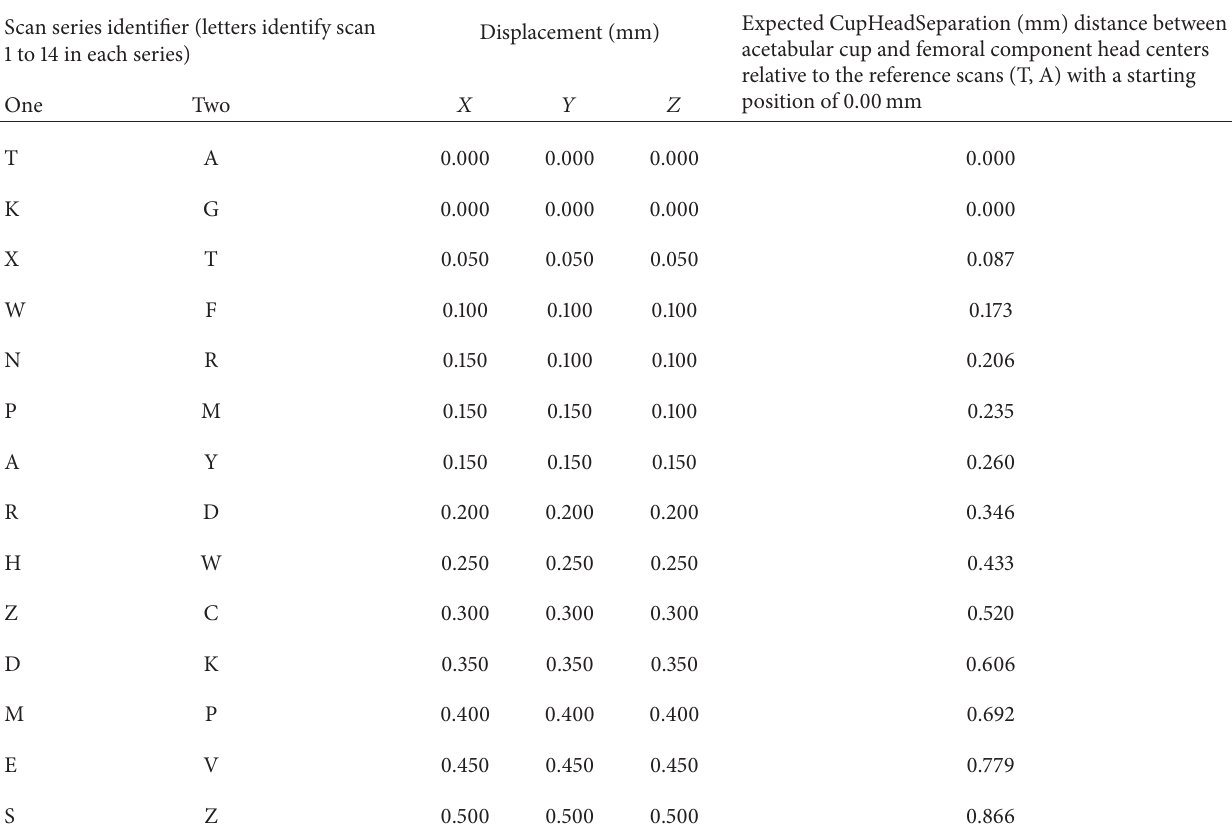
Table 1: Phantom displacement and distance difference as determined from the micrometer settings. Scan series identifier (letters identify scan relative to the reference scans (T, A) with a